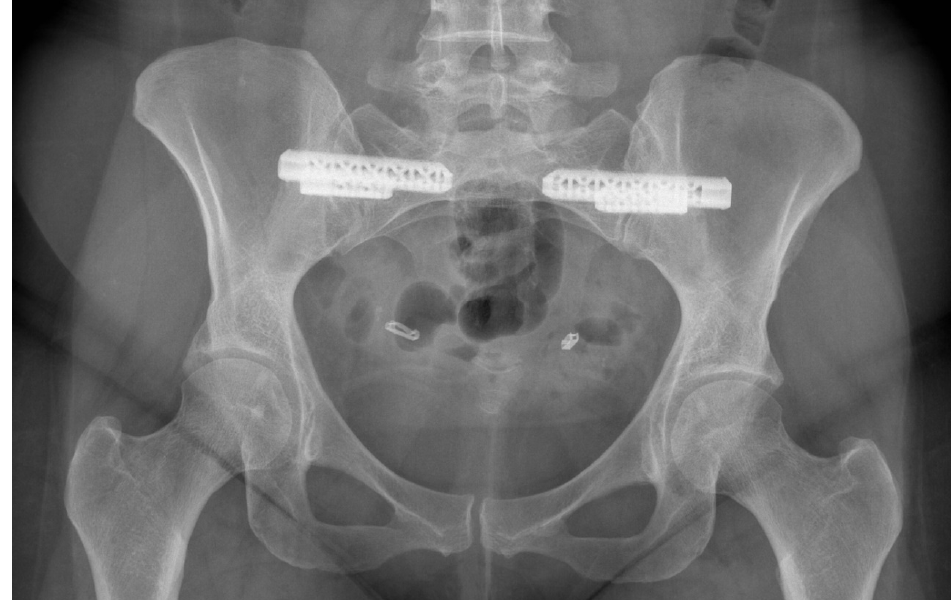
Figure 6. Anteroposterior pelvic radiograph in a 38-year-old female with hypermobility syndrome suffering from chronic sacroiliac joint pain who underwent stabilisation of bilateral sacroiliac joints with the iFuse implants.